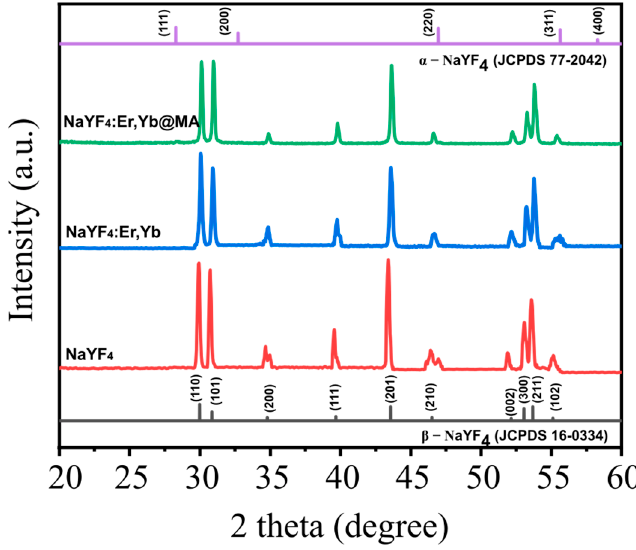
Figure 2. XRD patterns of NaYF 4 un-doped, co-doped NaYF 4 :Er,Yb, and polymer ligand